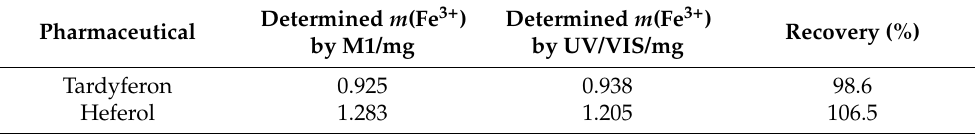
Table 7. Determination of ferric cations in digested